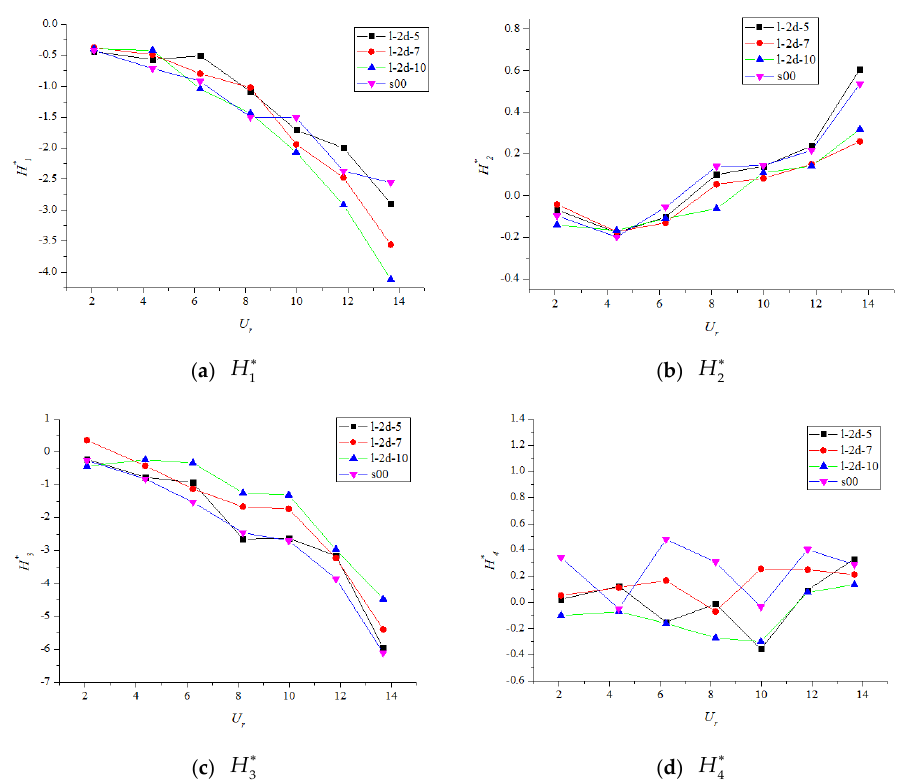
Appl. Sci. 2020 , 10 , x FOR PEER REVIEW Figure 7. ( a – d ) Flutter derivatives 